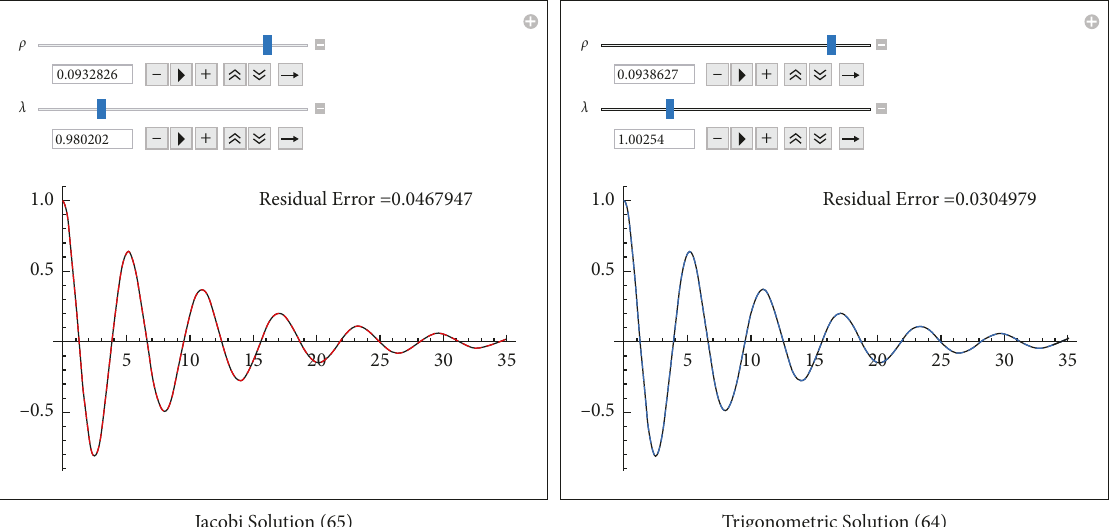
Figure 1: Approximate analytical solutions. Comparison between the numerical solution and the analytical approximate solutions-elliptic and